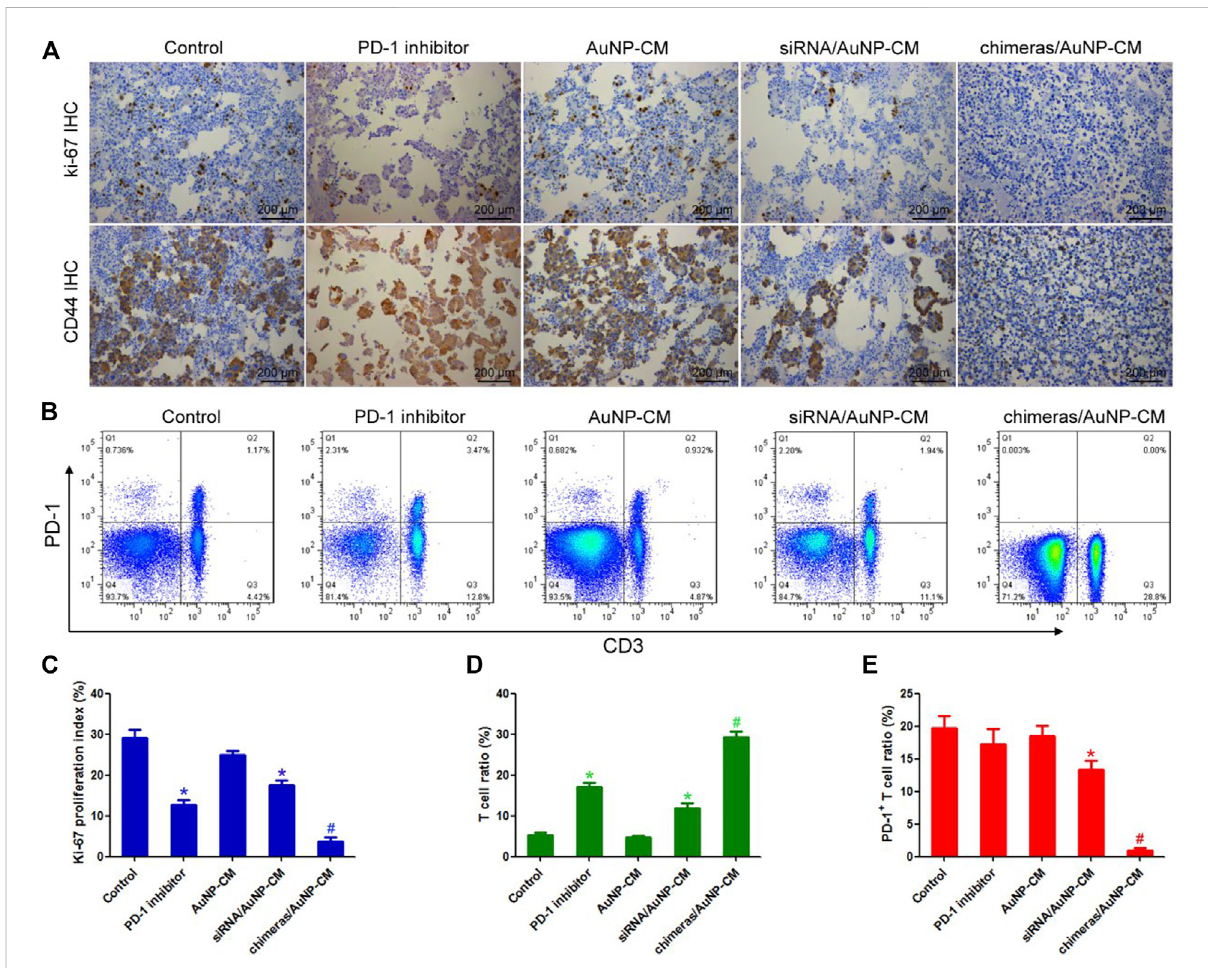
FIGURE 5 Effectsofchimeras/PEI/PEG/AuNP/collagenmembraneonimmunotherapyformalignantpleuraleffusion (A) Immunohistochemistrywasused to detect the expression of Ki-67 and CD44 (B) The proportion of T cells and PD-1 + T cells in pleural effusion was detected by fl ow cytometry (C) Compared with PD-1 inhibitor group, ki-67 proliferation index and CD44 expression of cancer cells in the chimeras/AuNP-CM group were signi fi cantly decreased (D,E) Compared with the PD-1 inhibitor group, the number of T cells in the chimeras/AuNP-CM group was signi fi cantly increased, while the proportion of PD-1 + T cells was signi fi cantly decreased. * p < 0.05 (n = 10) versus Control. # p < 0.05 (n = 10) versus siRNA/AuNP- CM. Values are mean ±